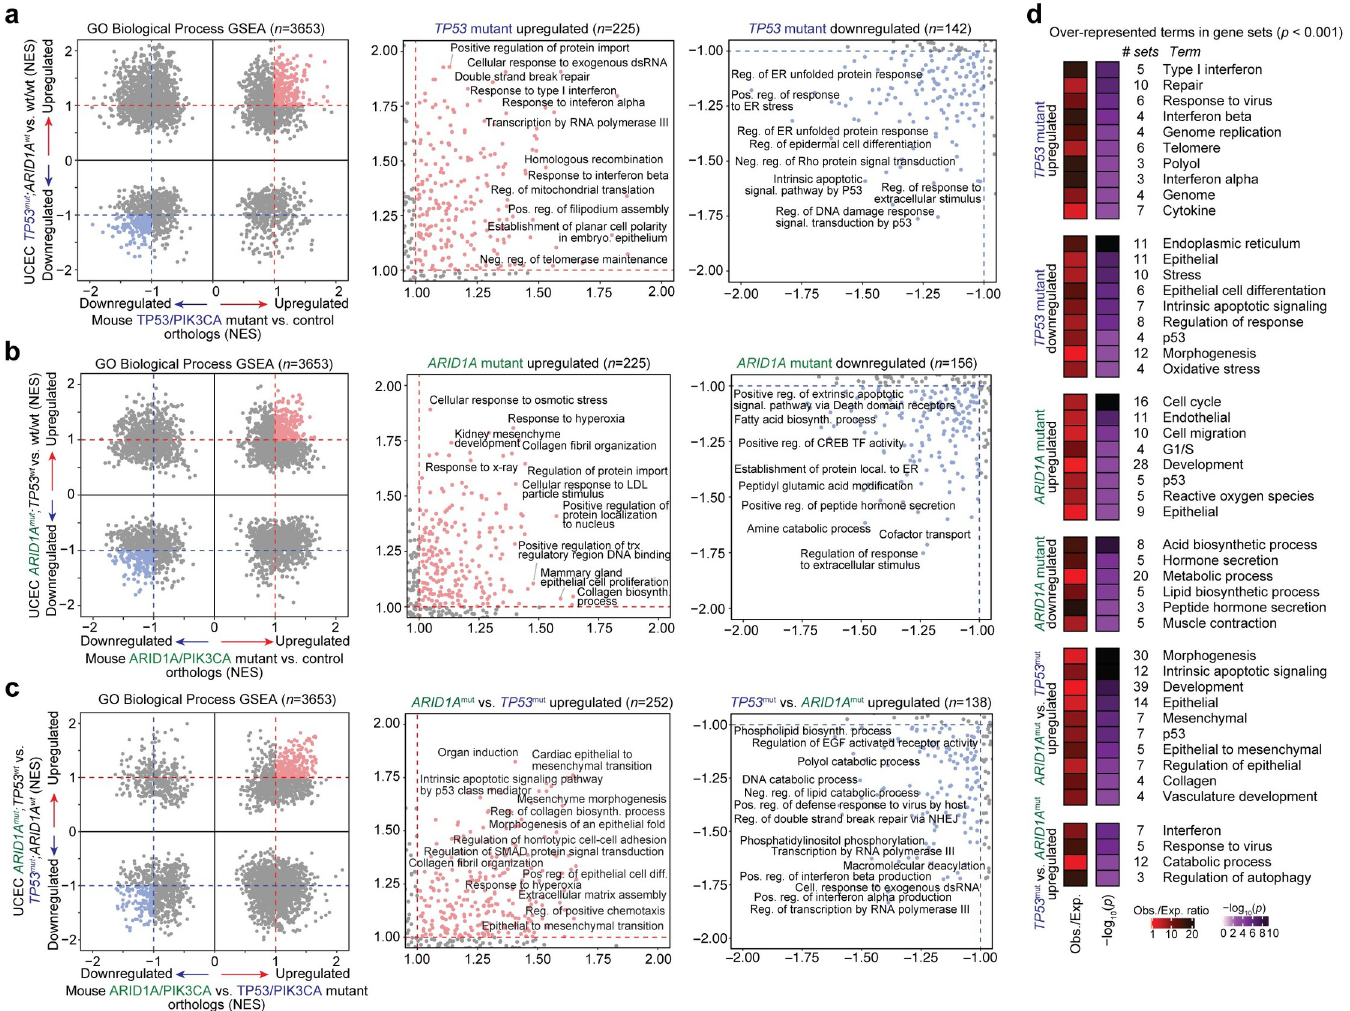
Fig 4. Pathway analysis of TP53 and ARID1A regulated expression programs in human disease and mouse models. a - c, Various Broad GSEA results for GO Biological Process gene sets ( n = 3653) comparing TP53 and ARID1A mutant human UCEC tumors and genetically engineered mouse models: ( a ) TP53 mutant, ARID1A wild-type vs. wild-type/wild-type UCEC tumors compared to mouse endometrial epithelial cells from TP53/PIK3CA mutants vs. controls; ( b ) ARID1A mutant, TP53 wild-type vs. wild-type/wild-type UCEC tumors compared to mouse endometrial epithelial cells from ARID1A/PIK3CA mutants vs. controls; ( c ) ARID1A mutant, TP53 wild-type vs. TP53 mutant, ARID1A wild-type UCEC tumors compared to mouse endometrial epithelial cells from ARID1A/PIK3CA mutants vs. TP53/PIK3CA mutants. Presented are the overview of GSEA results (left) with zooms into shared upregulated (NES > 1, center) and shared downregulated (NES < -1, right) gene sets. Representative examples of highly enriched gene sets are labeled. d , Significantly over-represented terms in enriched gene sets (|NES| > 1) highlighted in a - c . Statistic is hypergeometric enrichment. See Materials and Methods for enrichment analysis framework.